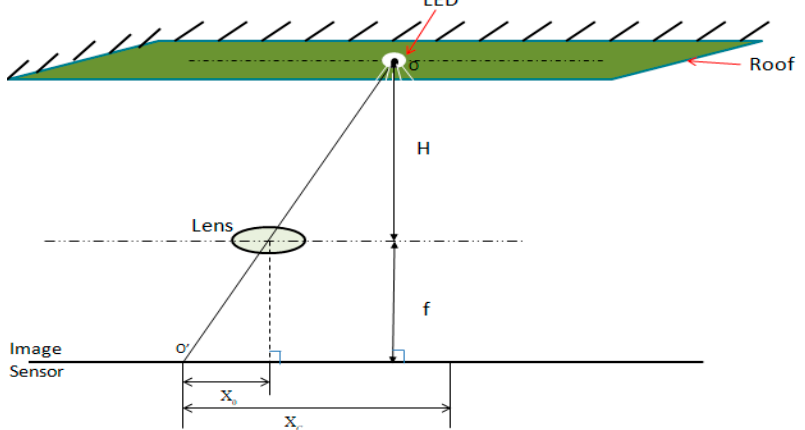
Figure 4. The geometrical relationship between the Light Emitting Diode (LED) and the image sensor. The world’s coordinates of the image sensor is defined as z (cid:2922) (t) ( x (cid:2922)(cid:2930) , y (cid:2922)(cid:2930) , z (cid:2922)(cid:2930) ), where dx and dy